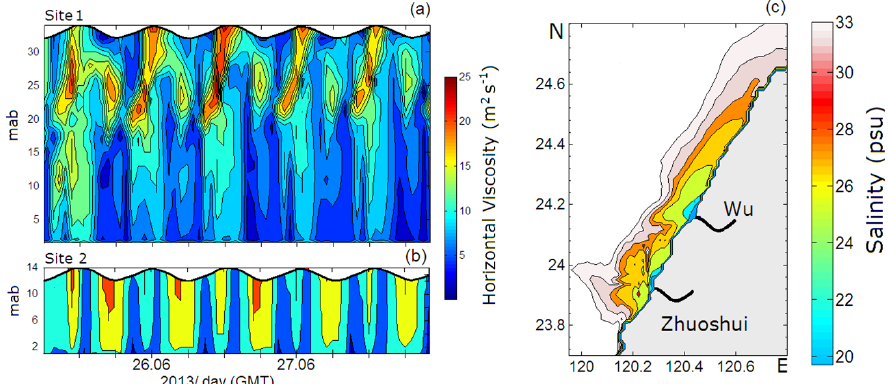
Figure 11. Simulated time–depth variability of horizontal diffusivity, K L , at (a) Site 1 (Wu River area) and (b) Site 2 (Zhuoshui River area). Panel (c) presents the distribution of surface salinity under large diffusivity ( C H = 0.7 in Eq. 1) for the flood phase corresponding to Fig. 6b.